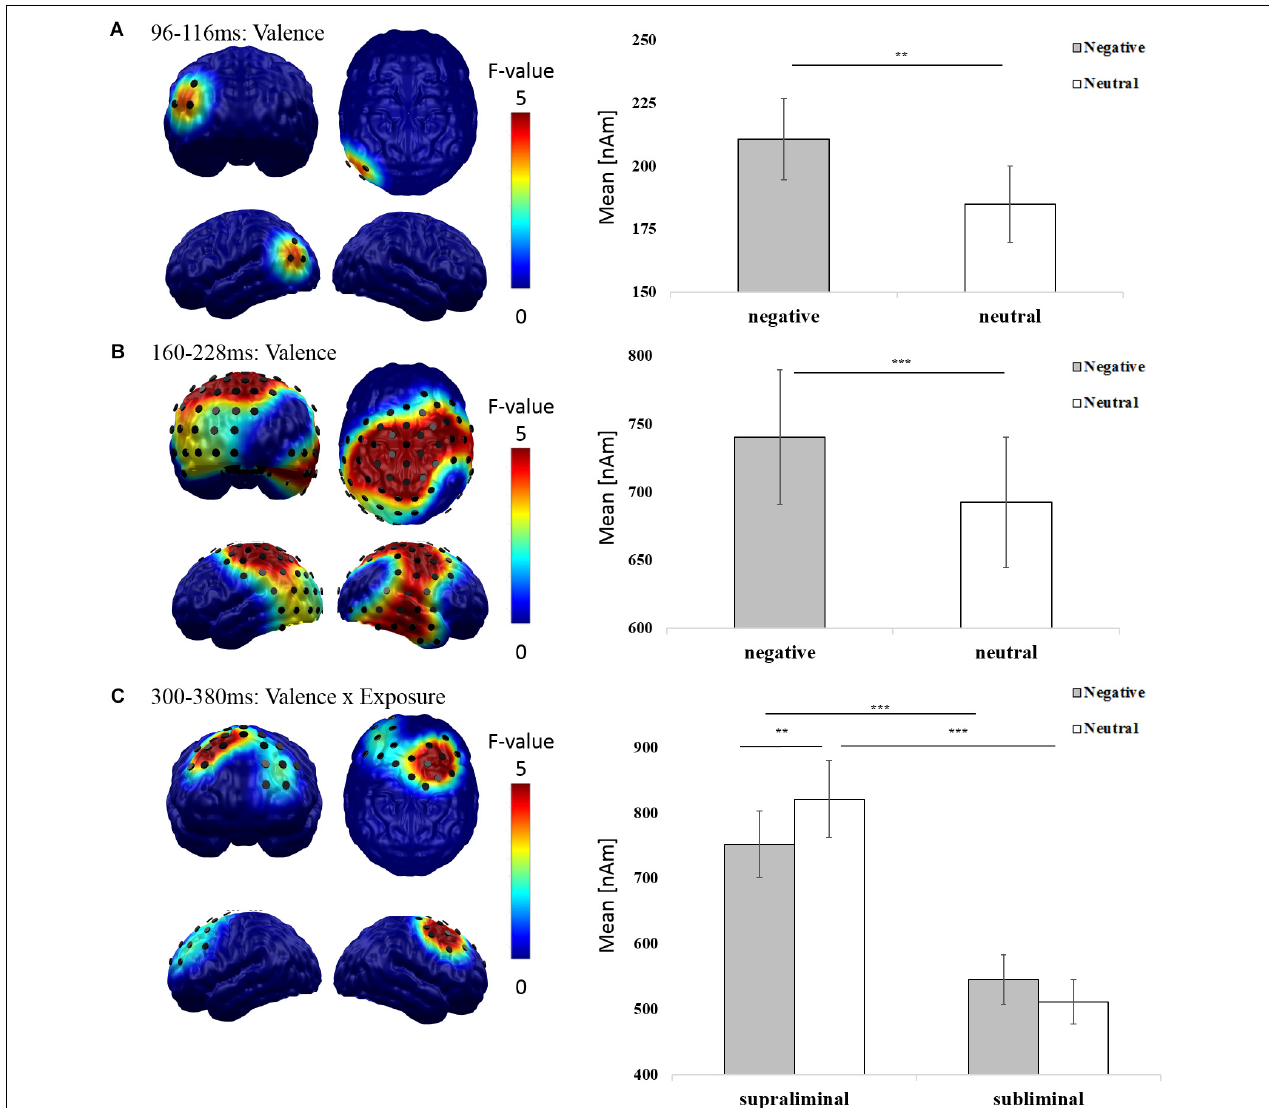
FIGURE 2 | Valence and exposure effects in neurophysiological Pre-cTBS data. The distribution of mean F -values for the (A) early (96–116 ms) and (B) mid-latency (160–228 ms) main effect of valence and the (C) late (300–380 ms) interaction of valence and exposure are displayed for all significant spatiotemporal clusters and masked at a significance level of p < 0.05 (sensor-criterion). Dipoles included in the spatiotemporal cluster ( p < 0.05, corrected) are superimposed in black color. The bar plot depicts the regional mean neural activity in the respective spatiotemporal clusters in response to negative (gray) and neutral (white) images. Error bars indicate the standard errors of the means. Significant results of post hoc t -tests (Bonferroni corrected) are indicated ( ∗ p < 0.05, ∗∗ p < 0.01, ∗∗∗ p <